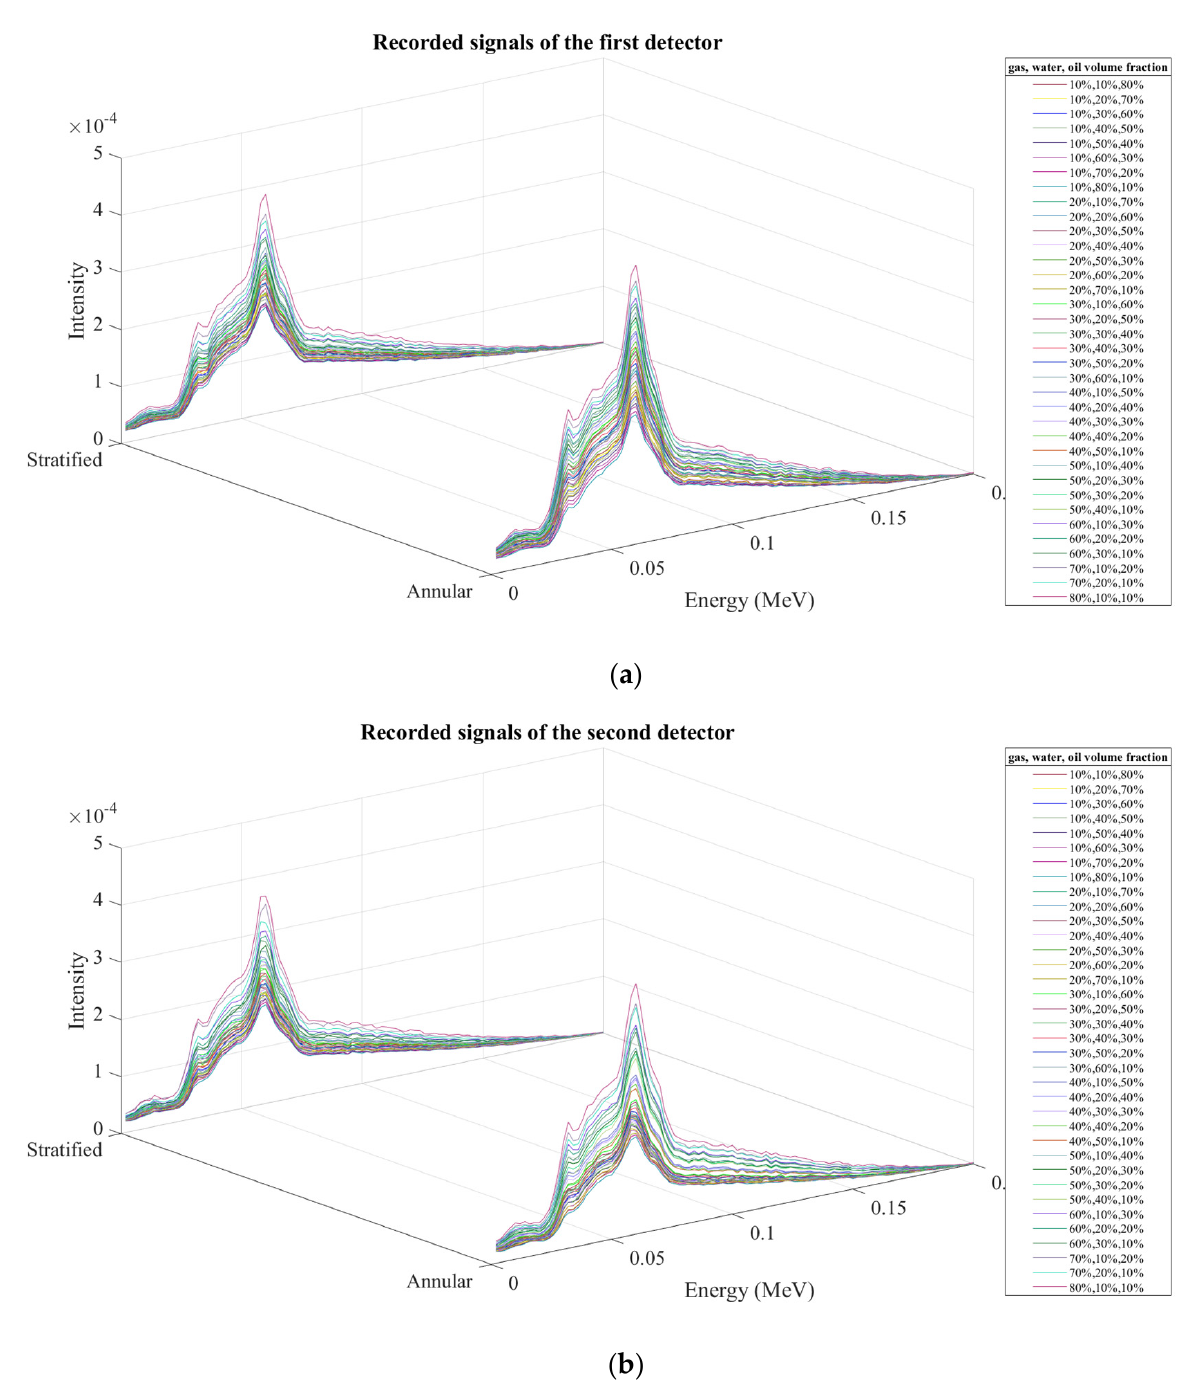
Figure 4. The signals recorded by the ( a ) first and ( b ) second detectors correspond to simulated flow regimes in different volume percentages.